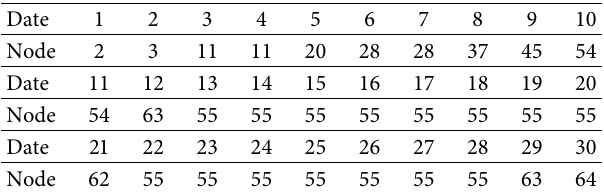
Figure 15: Comparison of remaining food. Table 9: The best strategy under Level 2.